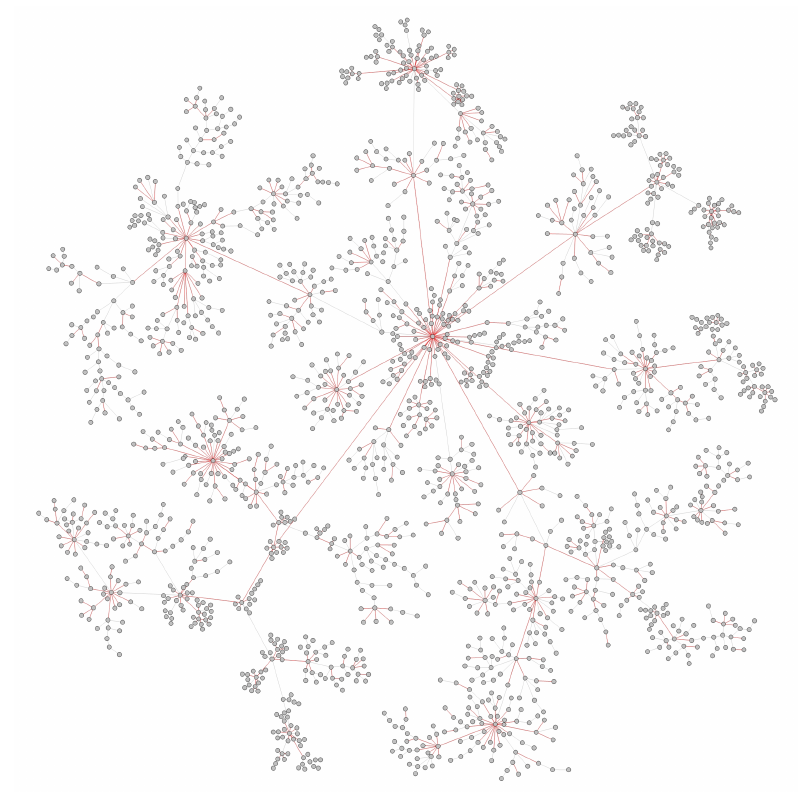
Figure A4. Abnormal edges in Alberta transmission network.